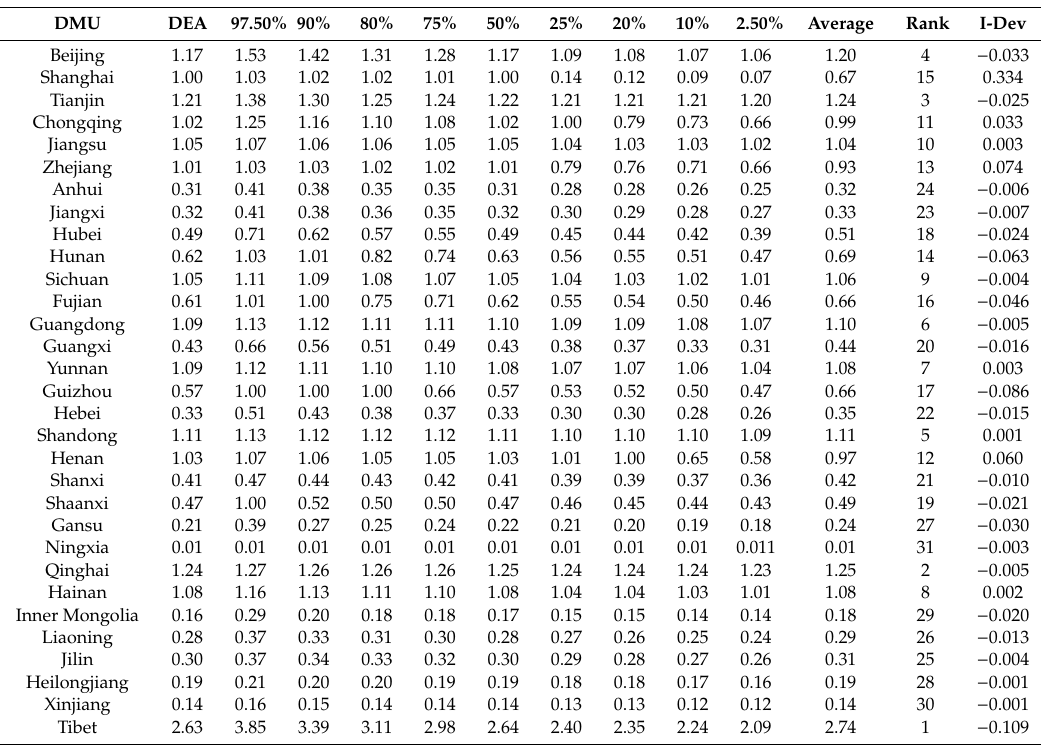
Table 3. Results of water resources’ use e ffi ciency in China with resampling data envelopment analysis (DEA).